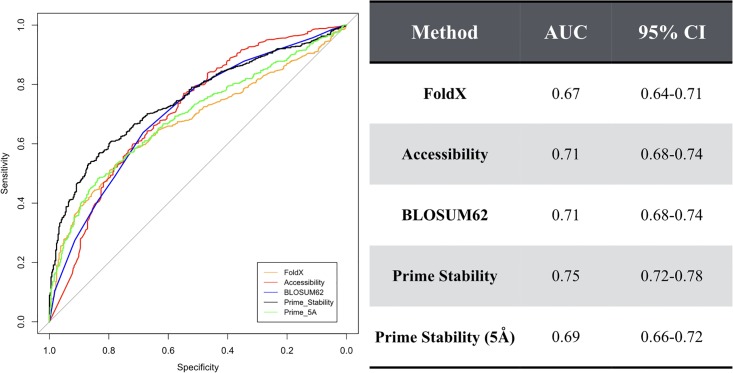
ROC curves for classifying functionally disrupting mutations on the beta lactamase dataset.This dataset is composed of 990 single-point mutations with measured changes in their minimum inhibitory concentration (MIC). The five models include energy scores from FoldX, the solvent accessibility of a side chain, the score from the BLOSUM62 substitution matrix, the Prime Stability score, and the Prime stability score with a 5Å minimization cutoff. The area under the curve (AUC) for each ROC curve is shown on the right along with its 95% confidence interval (CI).